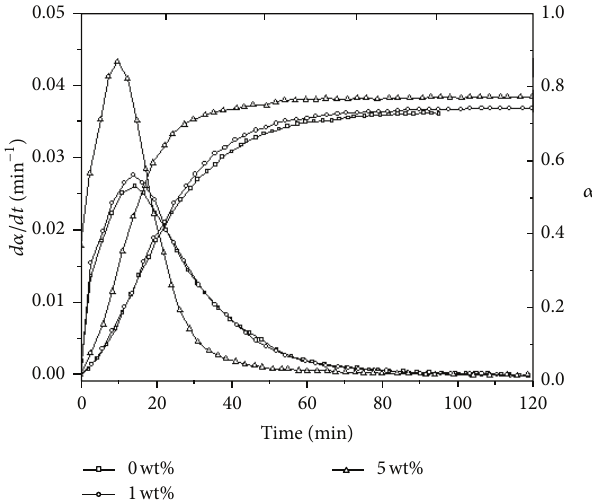
Figure 2: The reaction rate and extent of reaction of TGDDM/DDS epoxy and its nanocomposites as a function of time at 180 ∘ C. After [19].